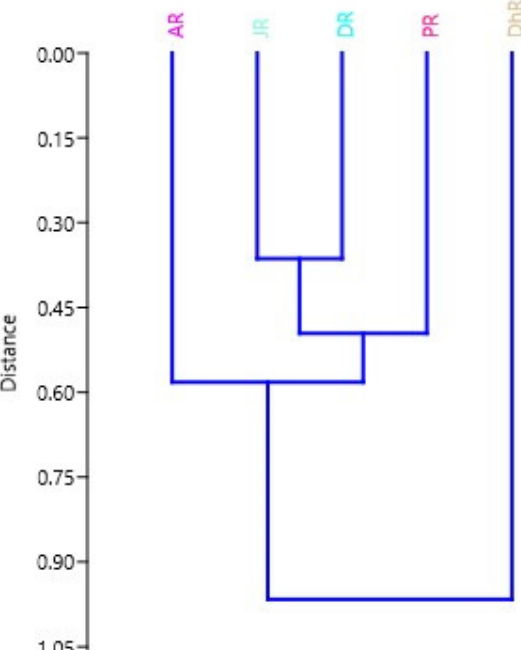
Figure 8. Dendrogram from truss measurements derived from UPGMA cluster analysis based on the Euclidean distance between the stock centroids. In the figure, stocks areas are shortened as JR, Jamuna River; AR, Atrai River; DhR, Dhorala River; DR, Danu River, and PR, Padma River.